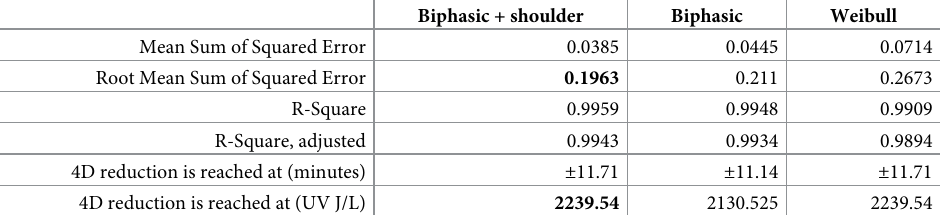
Table 3. Kinetics parameters obtained in the three mathematical models with best fit for UV-C inactivation of